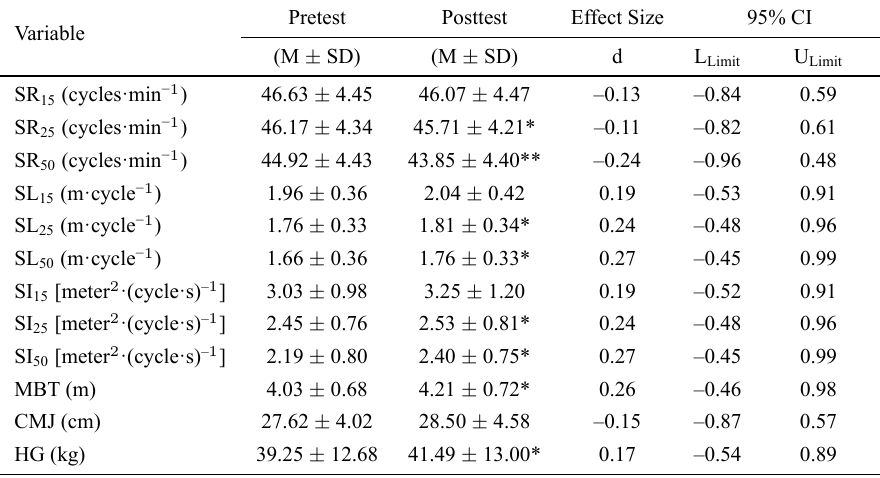
Table 1. Results in swimming kinematics and power variables in pretest and